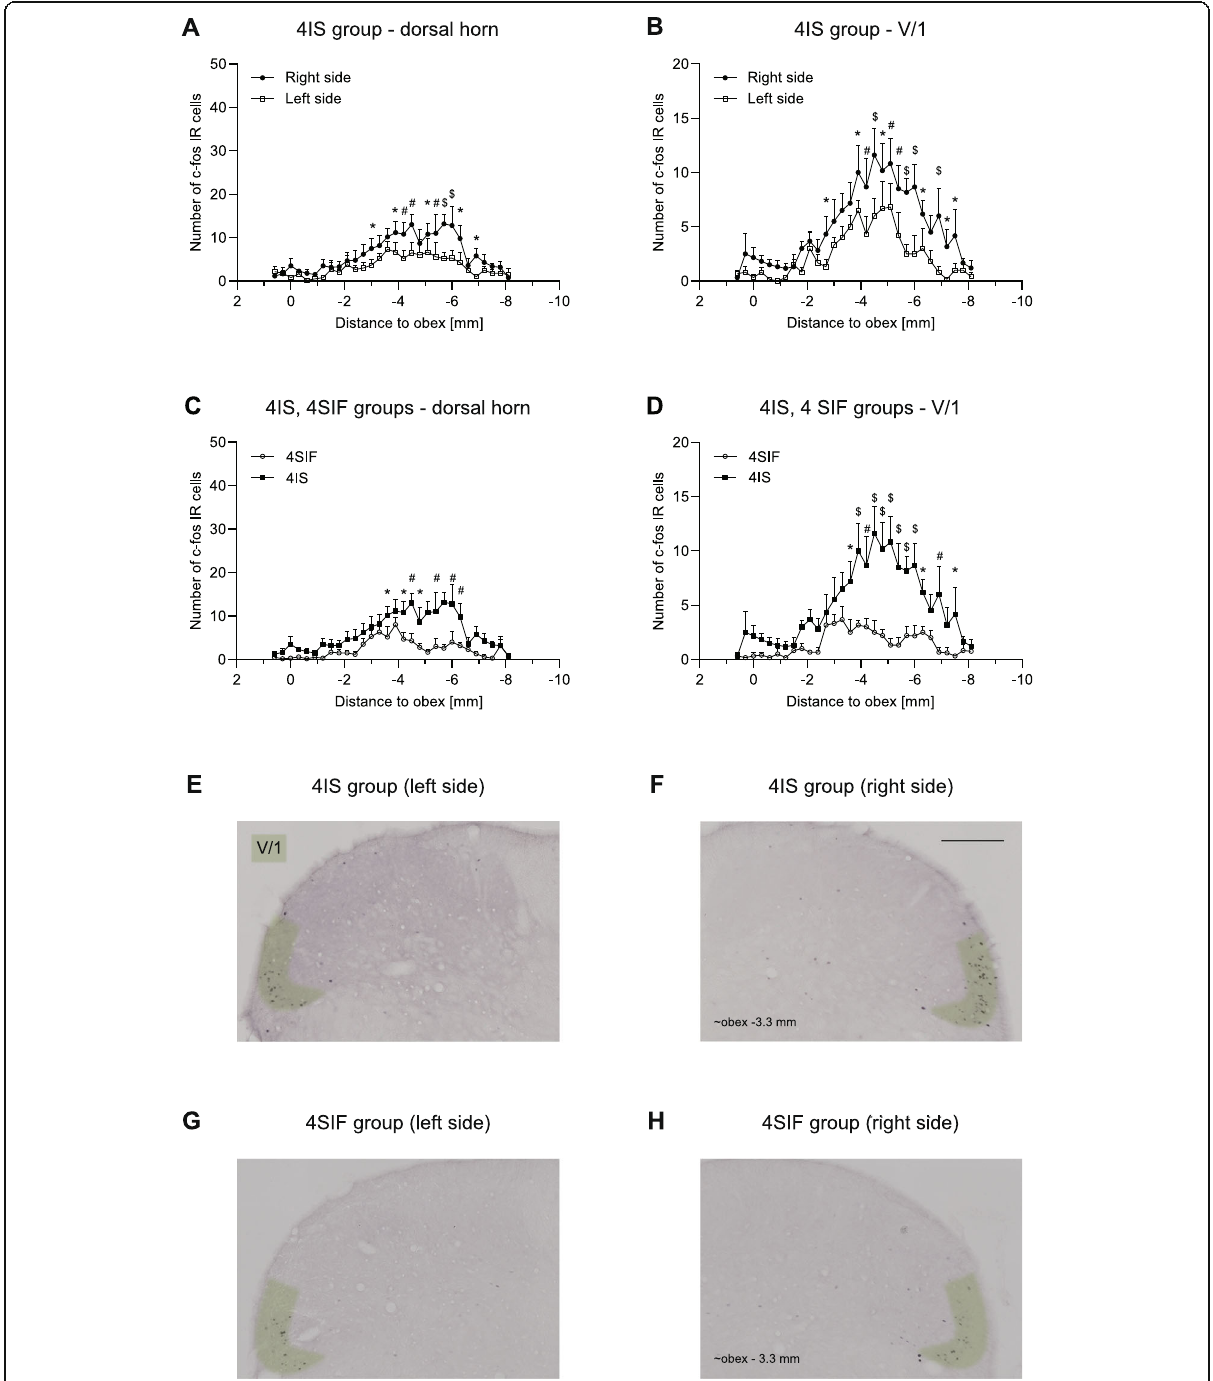
Fig. 6 Diagrams illustrate number of c-Fos positive cells in 4IS, 4SIF groups a - d . Photomicrographs showing c-Fos expression in the dorsal horns of 4IS e , f and 4SIF groups g , h . Green highlighting shows the V/1 area in the dorsal horn. Scale bar: 200 μ m. IS significantly increases the number of c-Fos IR neurons both in the whole dorsal horn a and the V/1 area b . IS increased the number of c-Fos positive cells compared to SIF in the whole dorsal horn c and in the ophthalmic nerve area d (mean + SEM; * p < 0.05, # p < 0.01, $ p <